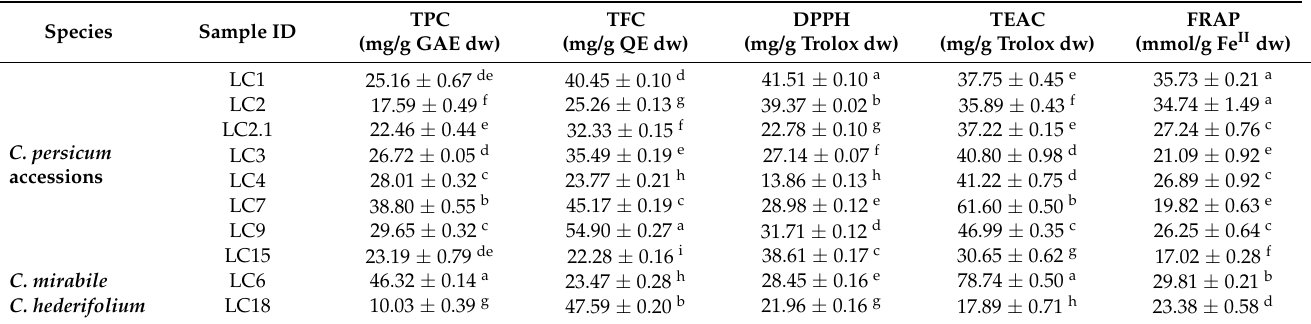
Table 4. Total phenolic (TPC) and flavonoid (TFC) content, and antioxidant properties of tested Cyclamen leaves